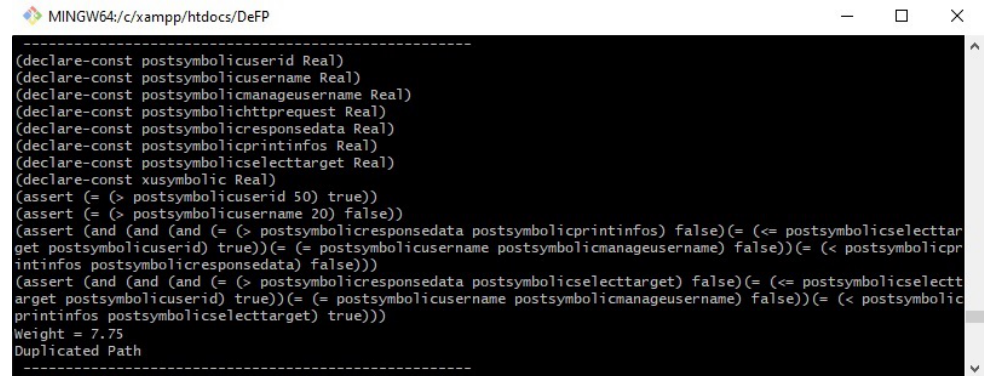
Figure A2. Example of duplicated feasible path detected in Peruggia application.